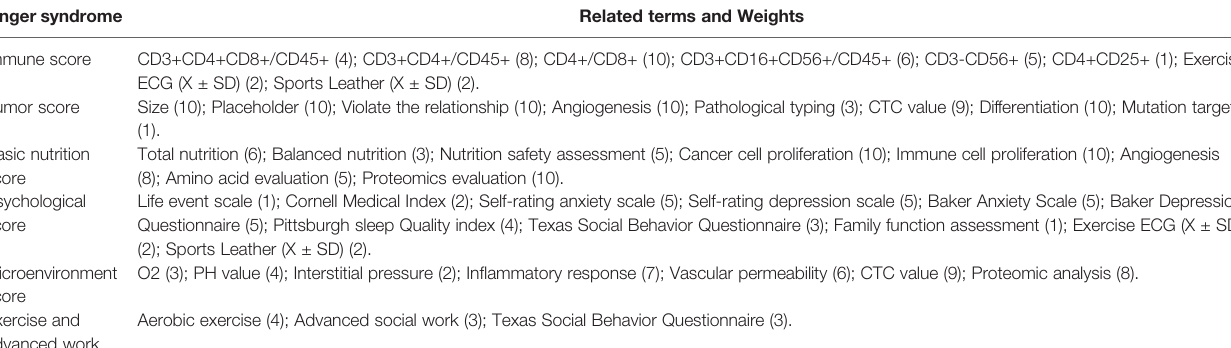
TABLE 1 | Cancer Patient Index Evaluation Criteria. Finger syndrome Related terms and